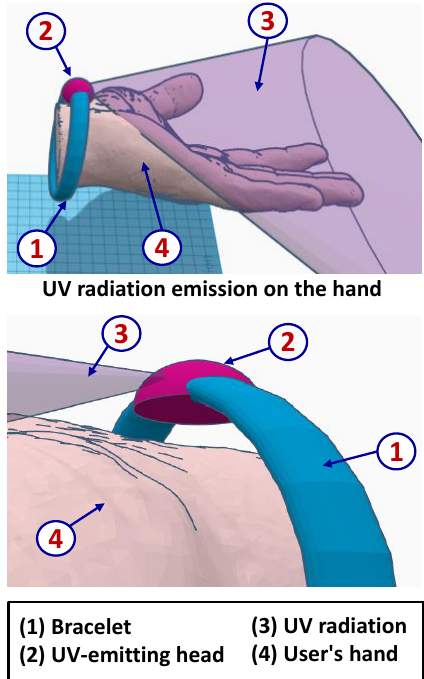
Figure 1. Coupling between the wristband and ultraviolet (UV) emitter.